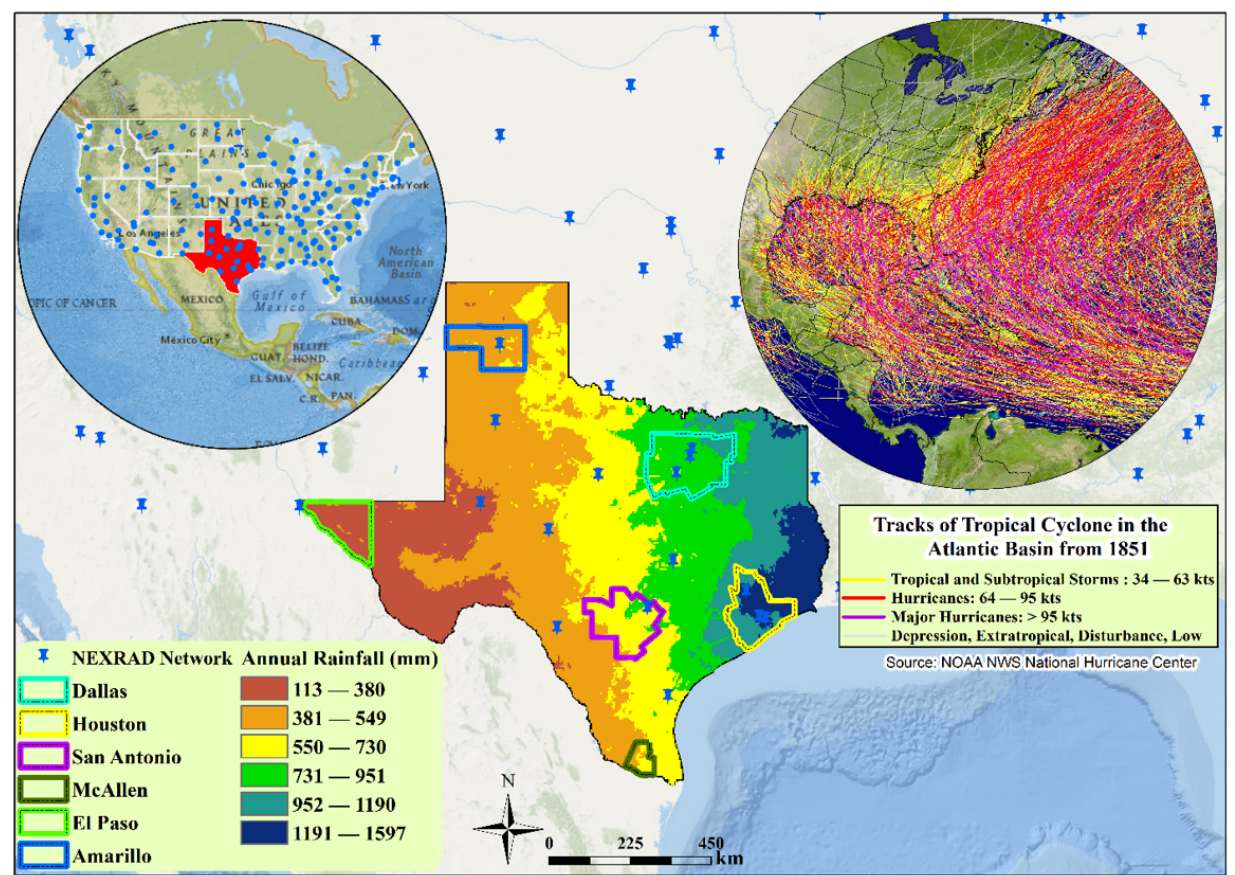
Figure 1. Annual average rainfall over the study area based on NEXRAD Stage-IV data (2002–2020) and the trajectory of the tropical cyclones in the Atlantic Basin from 1981 to 2017. The blue points display the spatial distribution of the NEXRAD weather radar network (old, new, and decommissioned). The geographical locations of major metropolitan areas of Texas are also shown.